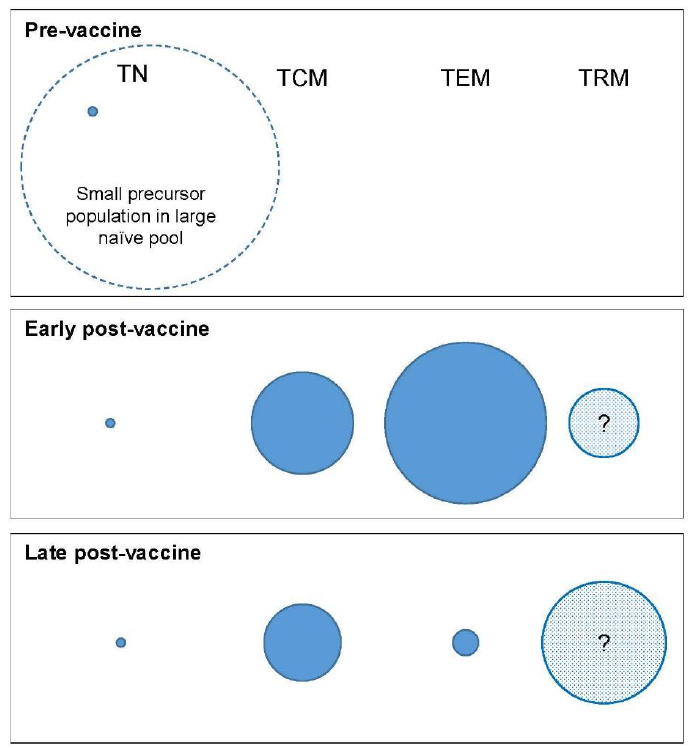
Figure 3. Compartment modelling in a vaccine response. Hypothetical simplified model of changes in compartment size following vaccination. The size of the circle represents schematically the relative number of cells of the corresponding phenotype—nave (T N ), central memory (T CM ), effector memory (T EM ), and tissue-resident memory (T RM ).